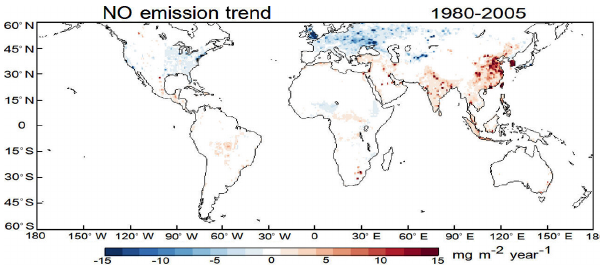
Figure 5. Trends in MERRA-2 GMI NO emissions (units mgm − 2 yr − 1 ) for 1980–2005. This figure is similar to Fig. 2, ex- cept for having an earlier 1980–2005 time